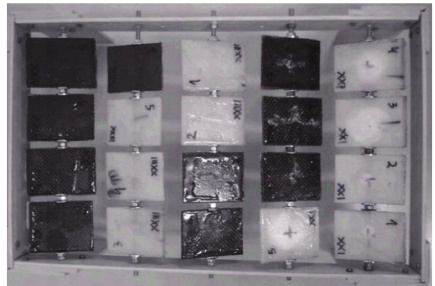
Figure 8: Natural ageing stand with fixed samples.